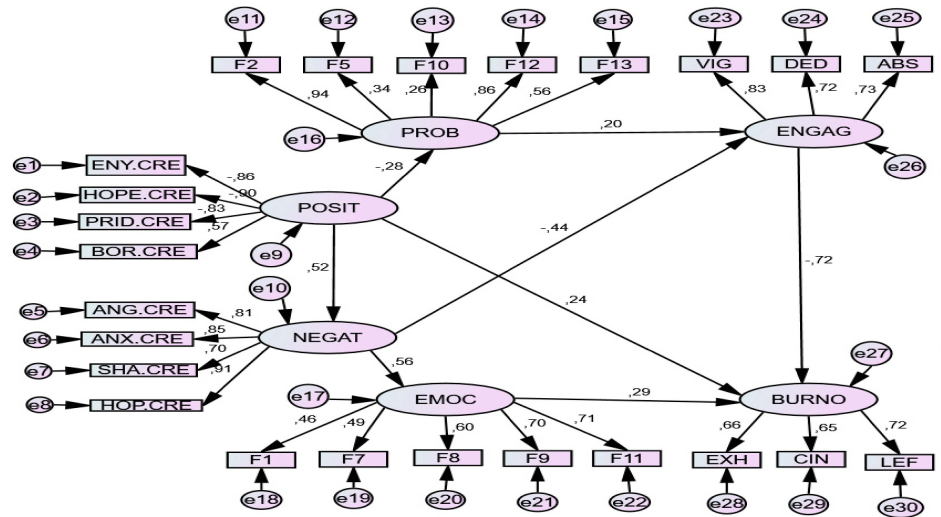
Figure 2. SEM model for Class Situation (Stress level 1) . Note . POSIT = Positive Achievement Emotions (Enjoyment, Hope, Pride); NEGAT = Negative Achievement Emotions (Anger, Anxiety, Shame,